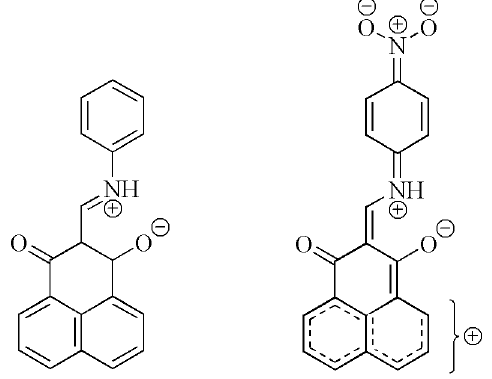
Figure 6. Zwitterionic forms of some compounds studied.